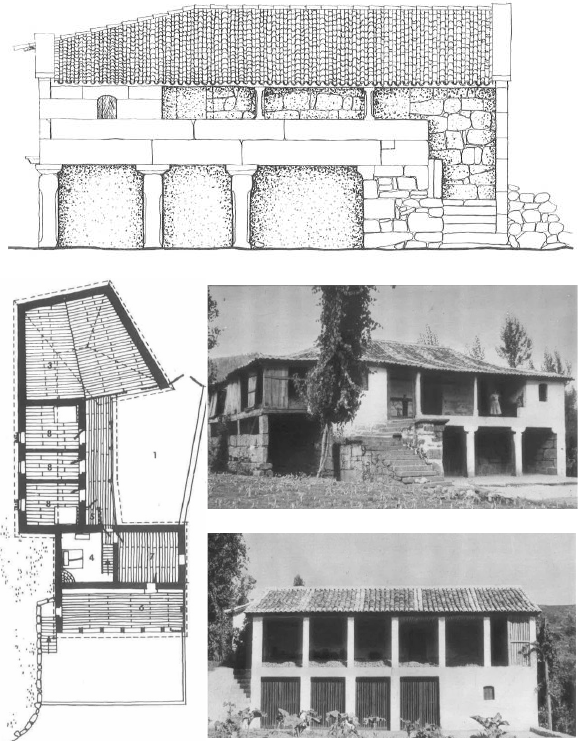
Figure 1. Elevation, plan and pictures of typical granite farmhouses ( casa de lavoura minhota ) in the Minho region ( Popular Architecture in Portugal ,